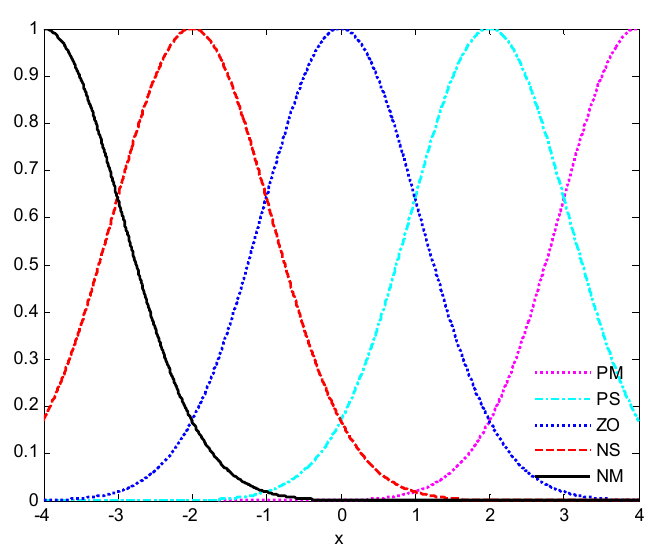
Figure 1. Fuzzy membership functions.